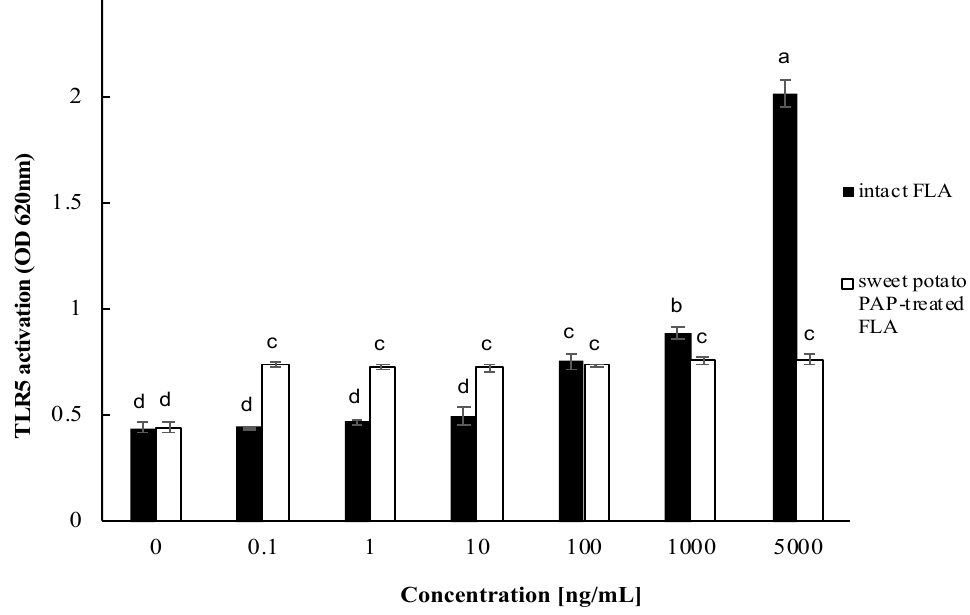
Figure 5. Effect of sweet potato PAP on PA FLA-induced TLR5 activation in HEK-Blue hTLR5 cells. HEK-Blue hTLR5 cells were cultured in 96-well plates at an initial concentration of 1.5×10 4 cells per well until 80% confluency. Different concentrations of PA FLA (0, 0.1, 1, 10, 100, 1,000, 5,000 ng/mL) were treated with 1 μL of sweet potato PAP (11.6 μg) for 6 hours. Then, enzyme treated FLA and intact FLA at each concentration were added to the cells. Activated TLR5 was monitored at OD 620 nm using the SEAP-based assay. The data were expressed as the mean and stand - ard errors from three experiments. PAP, purple acid phosphatase; PA FLA, Pseudomonas aeruginosa flagellin; TLR5, toll-like receptor 5; HEK-Blue hTLR5 cells, human TLR5-overexpressing HEK-293 cells; OD, optical density; SEAP, secreted alkaline phosphatase. a-d Means lacking common let- ters differ significantly